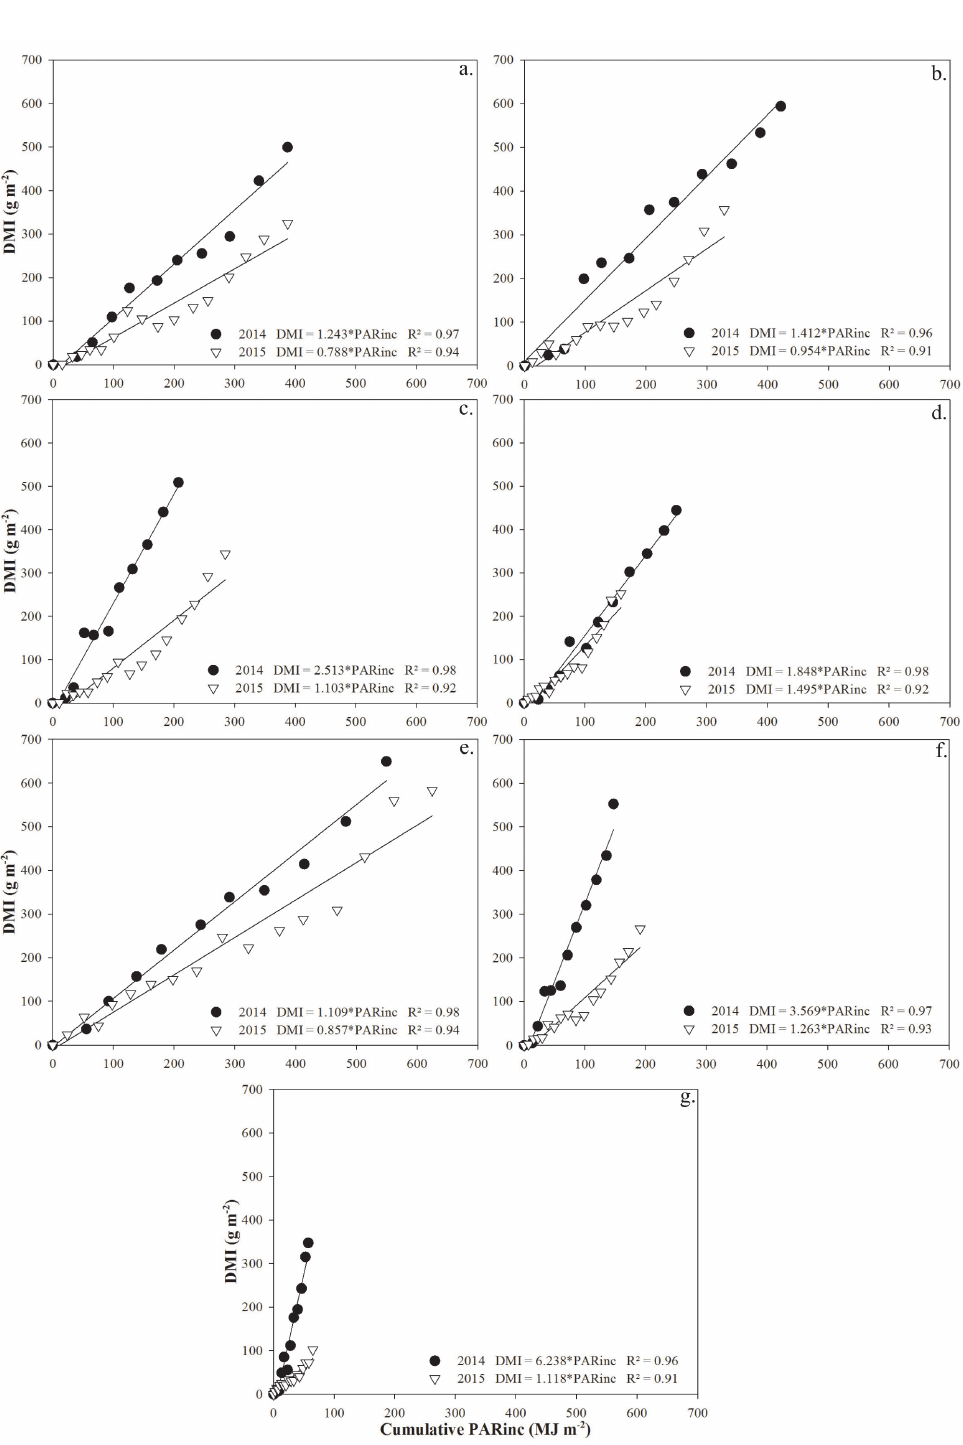
Figure 8 - Efficiency of the use of radiation (εb; g MJ -1 ) dual-purpose wheat cultivated in different cropping systems and with or without a cut (grazing simulation) in the crop years of 2014 and 2015 (Crop Seasons I and II, respectively). Dry matter increment (DMI); PArinc: Incident photosynthetically active radiation. S.parahyba Intercrop-I (a) ; P.rigida Intercrop-I (b) ; P.dubium Intercrop-I (c) ; and P.dubium Intercrop-II (d) ; Monoculture (e) ; Eucalyptus Intercrop-II (f) ; and Eucalyptus Intercrop-I (g)